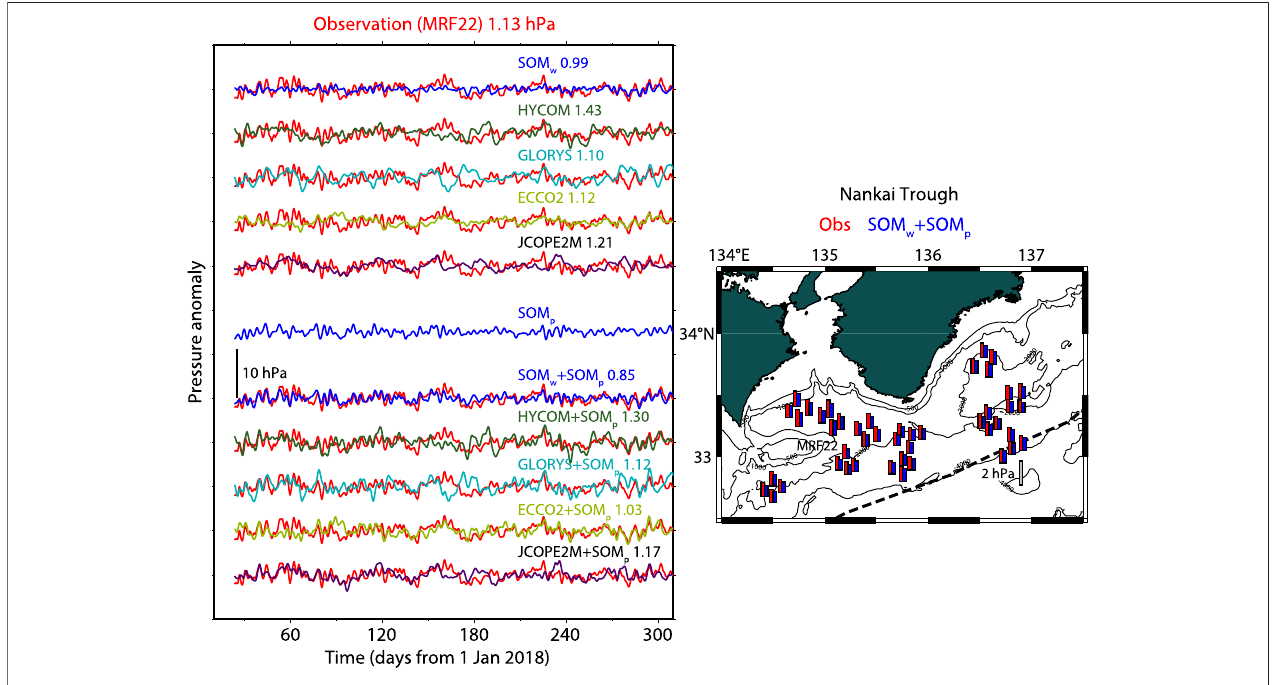
FIGURE 7 | Same as Figure 6 , but for result at MRF22 at the Nankai Trough. Comparisons with JCOPE2M is added.